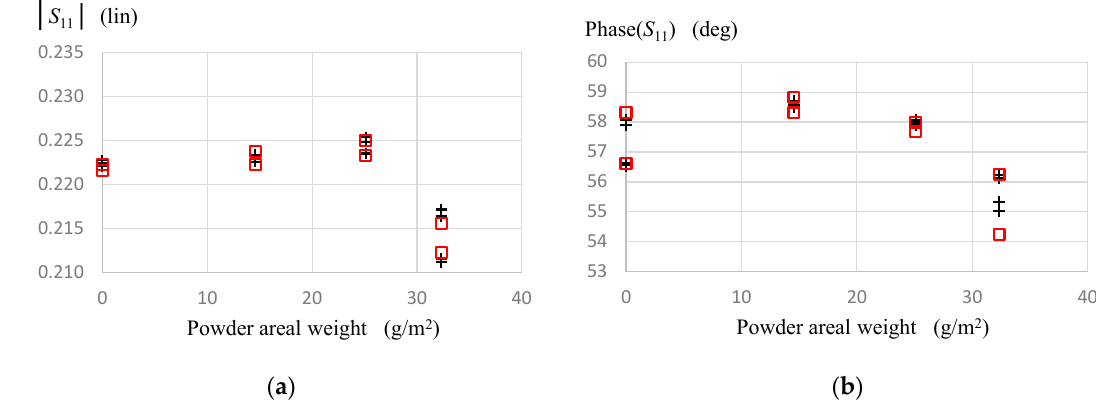
Figure 7. Measured amplitude and phase-shift of the complex reflection coefficient as a function of the powder areal weight ( + First measurement round, Second measurement round)—f = 10 GHz.